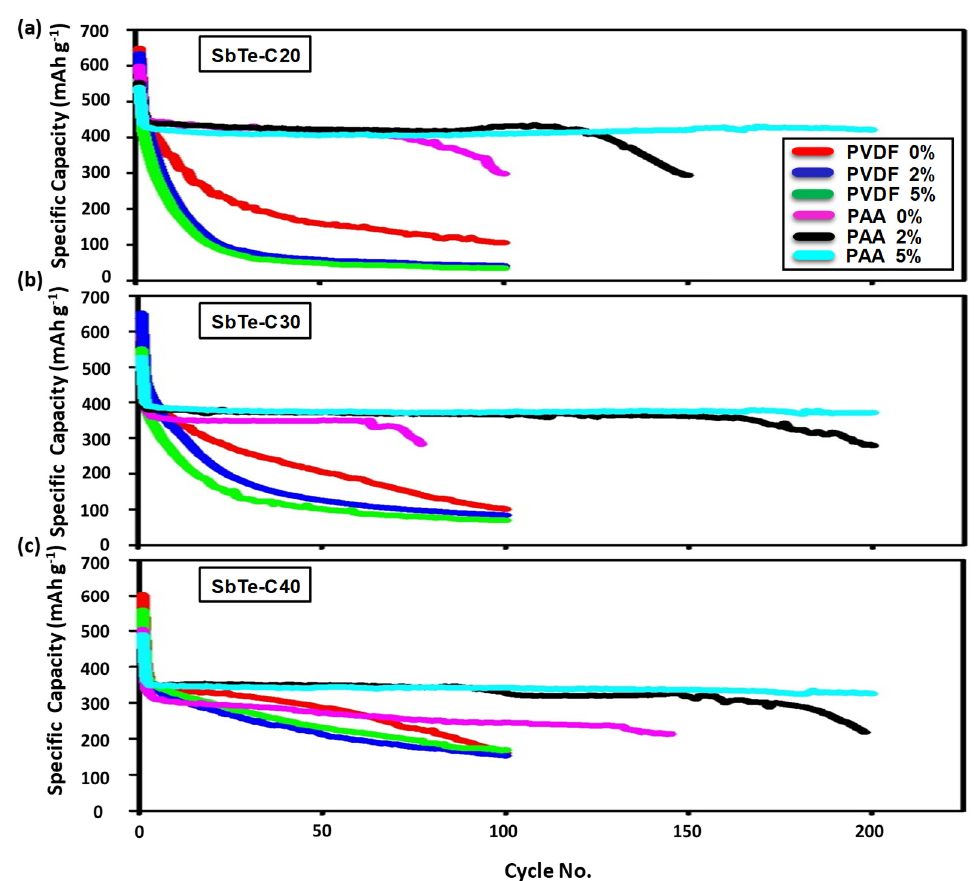
Figure 7. Cycling performance of the electrodes in this study prepared with the PVDF and PAA binders in cells with 0%, 2%, and 5% FEC added to the electrolyte: ( a ) SbTe-C20, ( b ) SbTe-C30, and ( c ) SbTe-C40.